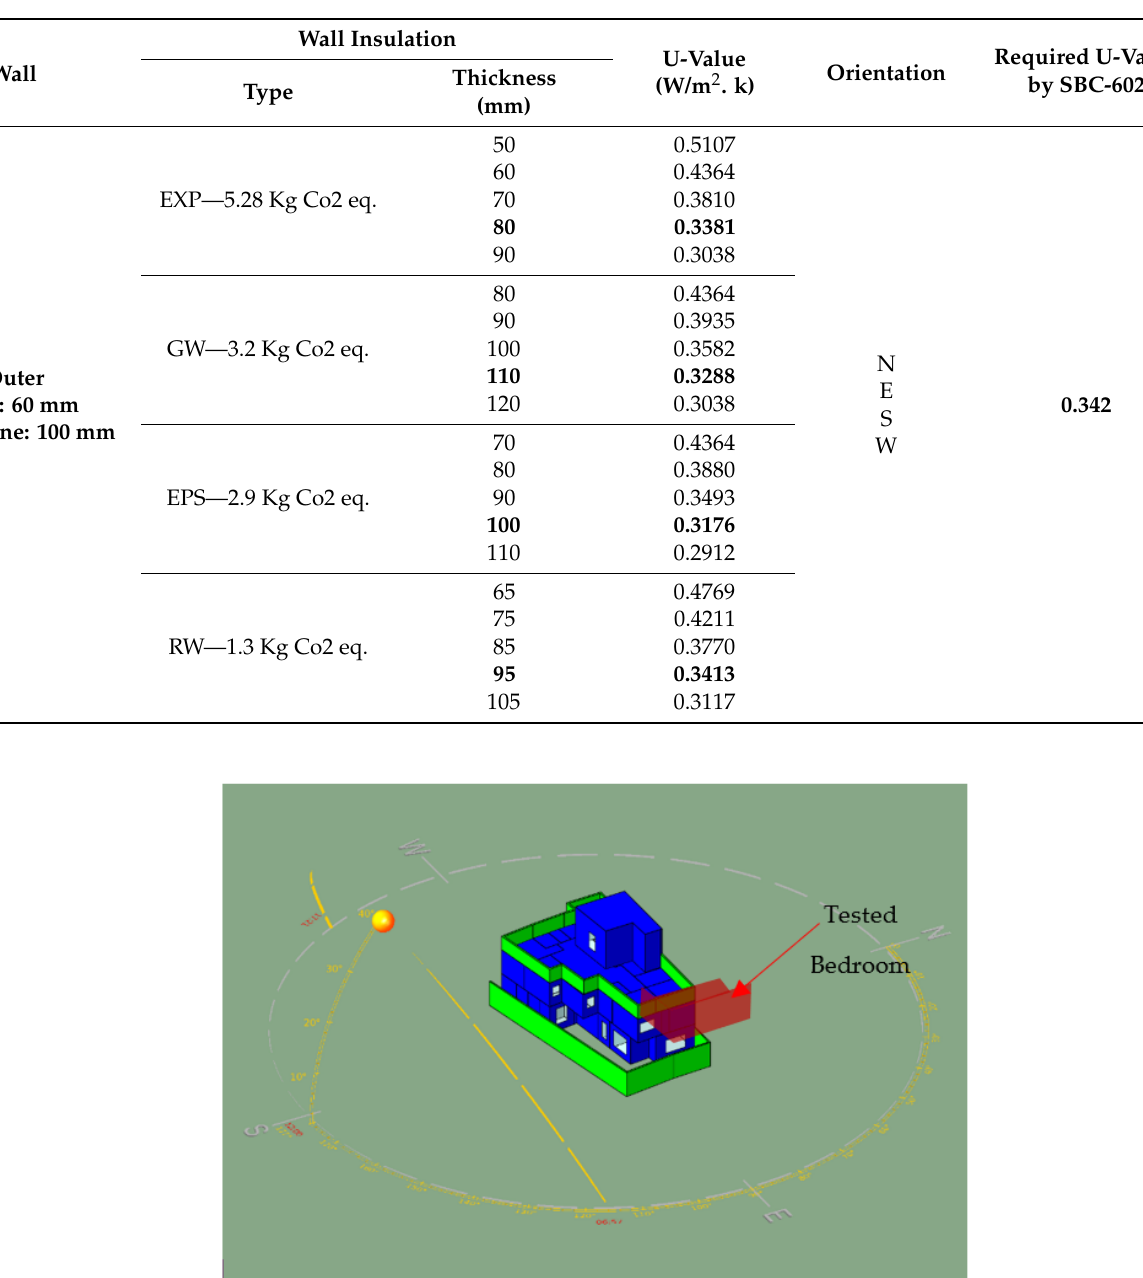
Table 3. Energy and LCA parameters for the insulation properties.